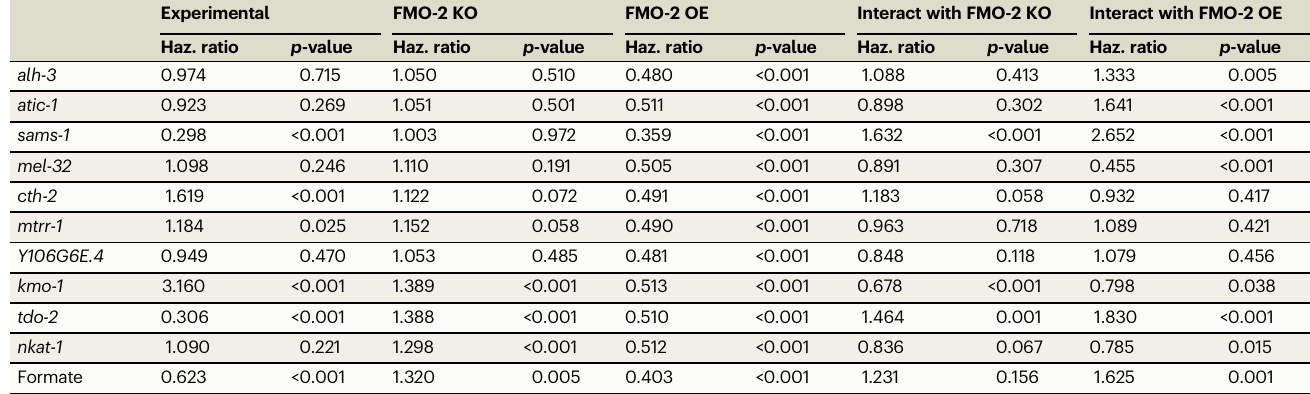
Table 1 | Cox regression analysis of OCM/tryptophan metabolism genes and fmo-2 modi fi ed strains lifespan data Experimental FMO-2 KO FMO-2 OE Interact with FMO-2 KO Interact with FMO-2 OE Haz. ratio p -value Haz. ratio p -value Haz. ratio Haz. ratio Haz.